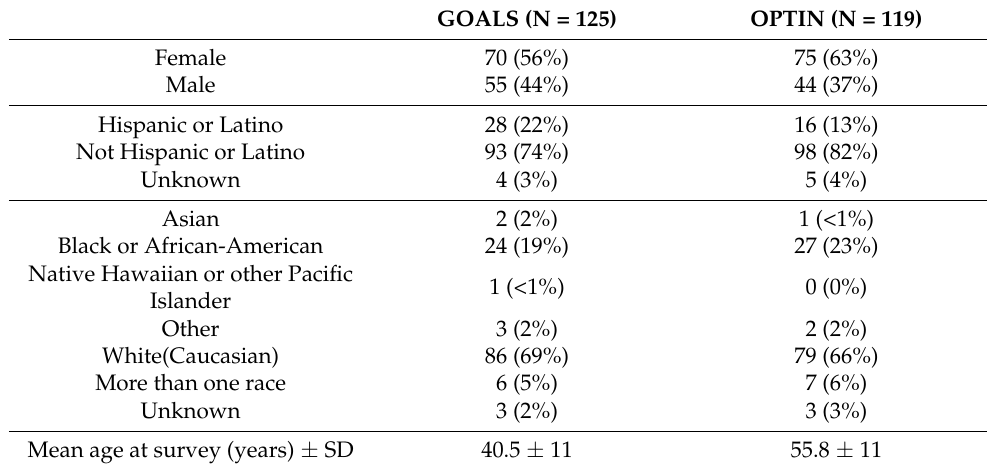
Table 1. Participant Demographics.